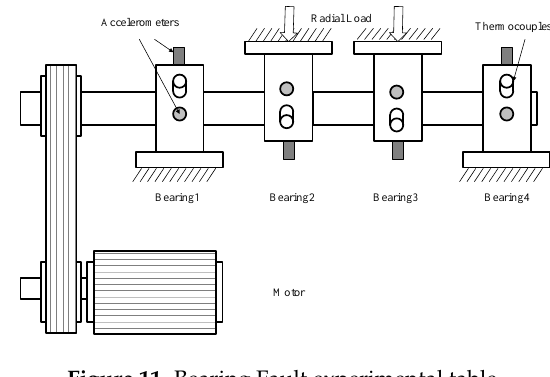
Figure 11. Bearing Fault experimental table. Table 2. The specific parameter of bearing.